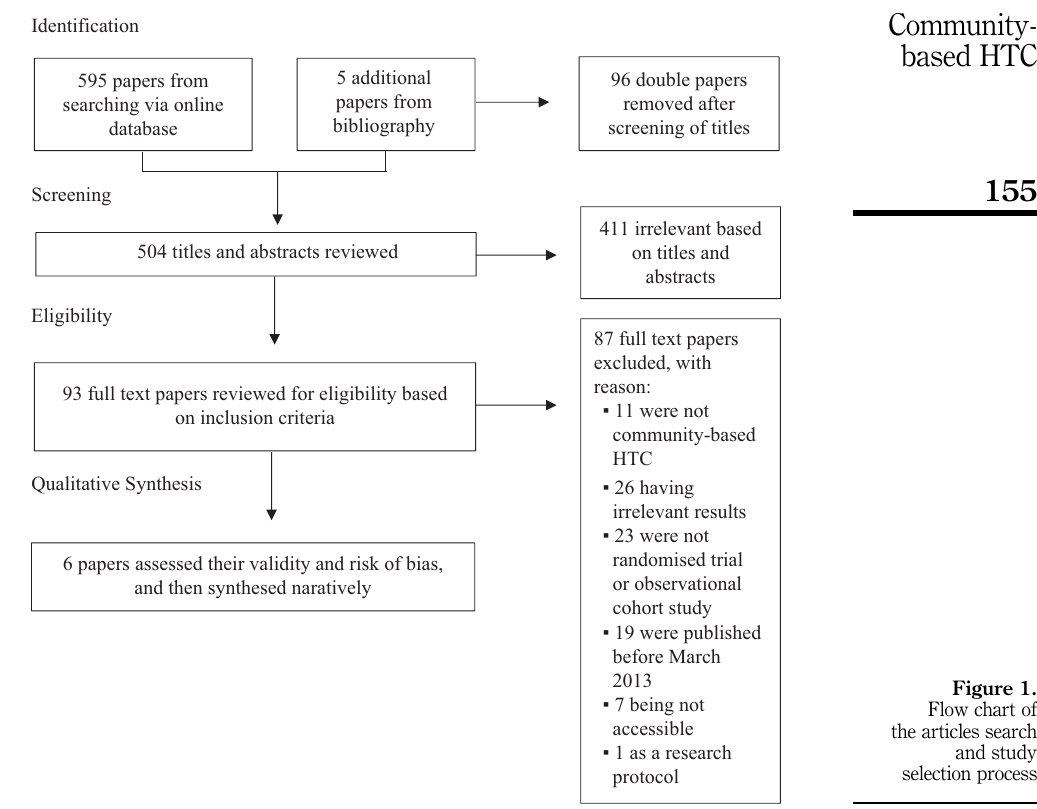
Figure 1. Flow chart